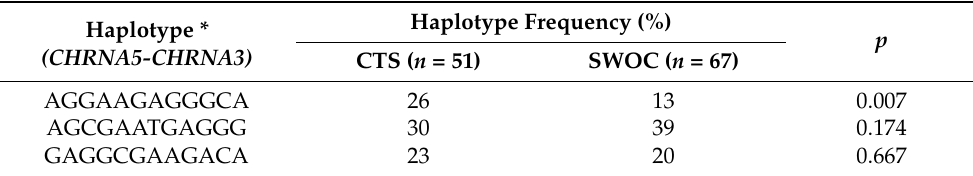
Figure 2. Haplotype in the CHRNA5-CHRNA3 loci between CTS and SWOC with a high Caucasian component (CEU) or a high Amerindian contribution (AME). Bp: base pairs. The analysis was performed with Haploview 4.2 [11]. CEU: high Caucasian component. AME: high Amerindian component. Table 4. Haplotype analysis in the groups with a high Caucasian